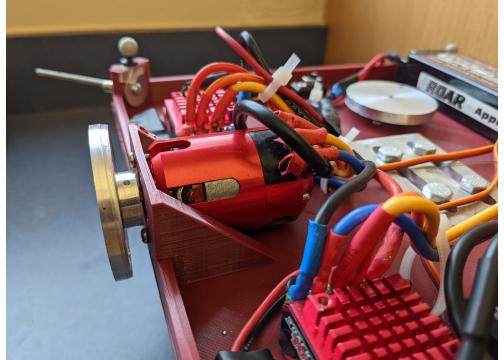
Figure 6. TrackStar 13.5T Brushless Motor and ESC Combo with custom manufactured flywheel.